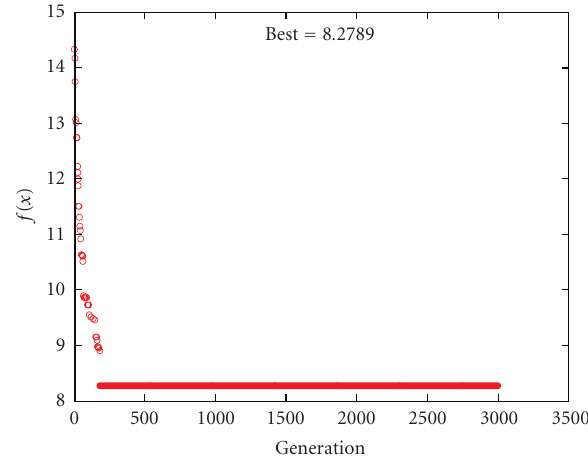
Figure 11: Convergence of a genetic programming run. weekly average solar radiation values of 1998 and 1999, in W/m 2 ; the prefix z indicates standardized variable.